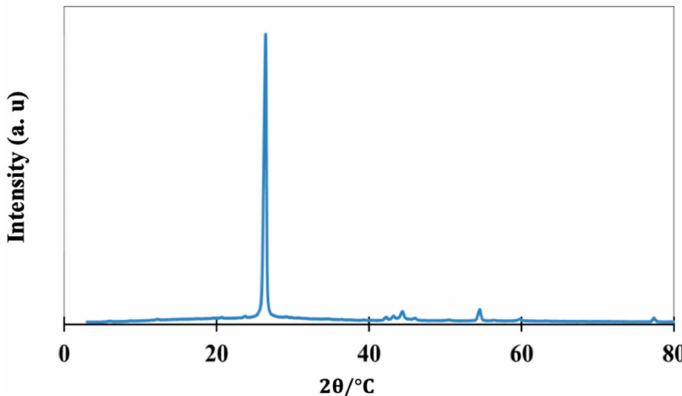
Figure 5. Results of XRD test conducted on carbon nanoparticles.